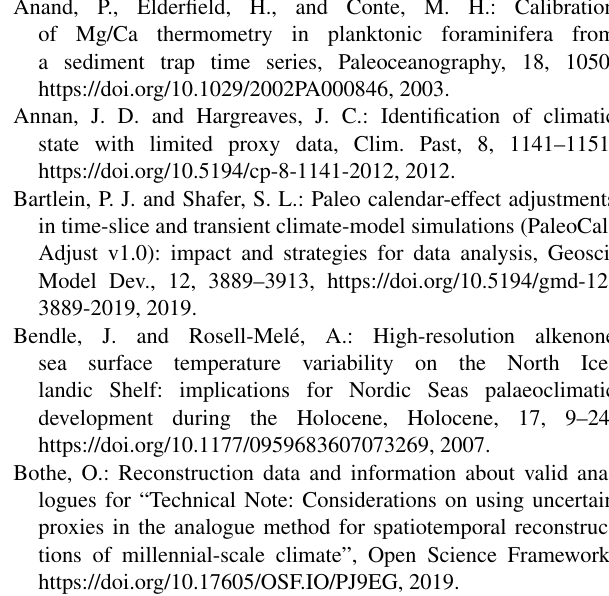
Table A1. Simulation data are available from a number of sources. Data from simulations for PMIP3 can be ob- tained from the Earth System Grid Federation, e.g., at the node (last access: 22 March 2021, ESGF, 2021). Last millennium ensemble data and TraCE-21ka output are available